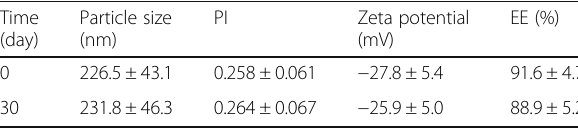
Table 2 The stability of s of 0.1% γ -PGA-coated